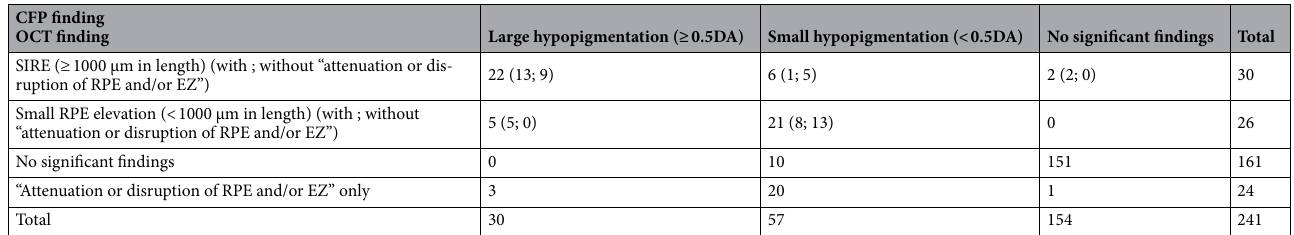
Table 2. Matching and concordance between the presence and size of hypopigmentation on color fundus photography and corresponding abnormal findings on optical coherence tomography. CFP = Color fundus photography; OCT = Optical coherence tomography; SIRE = Shallow irregular RPE elevation; EZ = Ellipsoid zone; kappa = 0.759, P < 0.001 (“Attenuation or disruption of RPE and/or EZ” only group was not included in the analysis, n = 217).